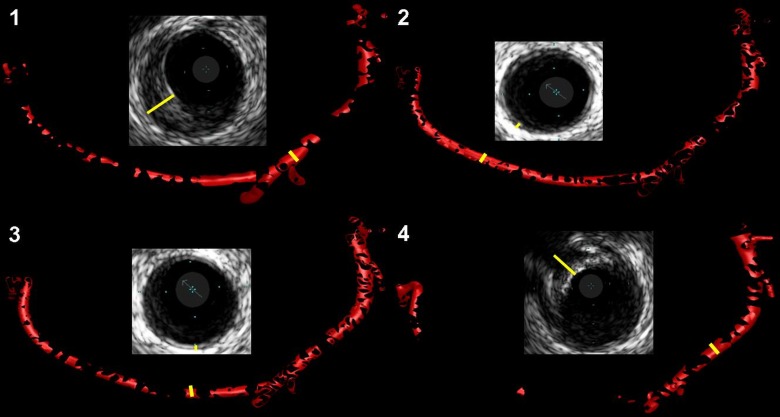
Vessel surface areas corresponding to different levels of endothelial shear stress (ESS).For each quartile of ESS a single model was reconstructed and used for correlation with intravascular ultrasound (IVUS). In quartile 1 (lowest ESS) and quartile 4 (highest ESS) a high prevalence of atherosclerotic plaque was observed whereas intermediate ESS (quartile 2 and 3) was mostly associated with no significant wall changes. The marked sites in the IVUS pictures correspond to marked areas on the surface models.